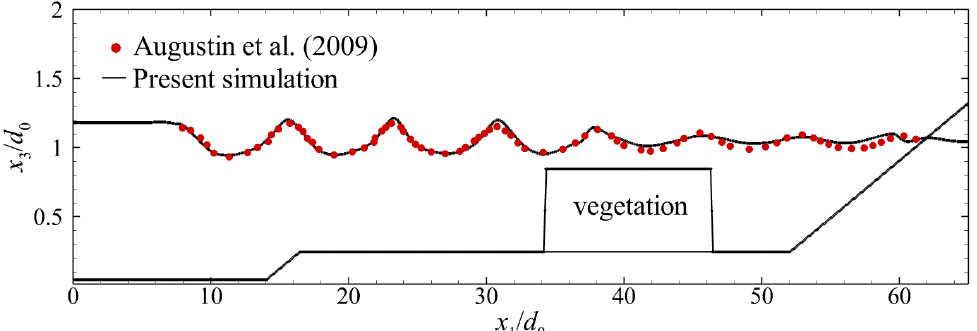
Figure 3. Numerical result of the free ‐ surface elevation along with the corresponding experimental result in Augustin et al. [31] where H = 12 cm and T = 1.5 s. The vegetation field comprises cylindrical stems of h v = 0.3 m and D = 12 mm with a density 97 stems/m 2 ( n eq = 0.99), Note that the axes are not in scale for clarity of the exposition.